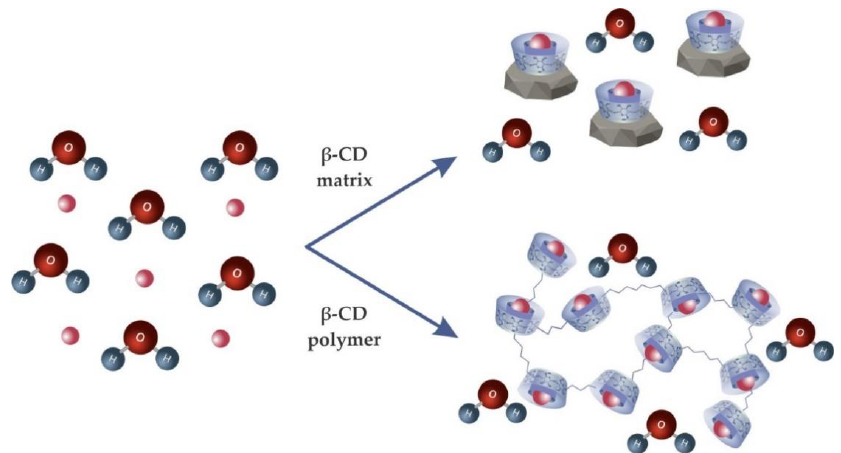
Figure 10. The role of β-CD as a dye adsorbent.